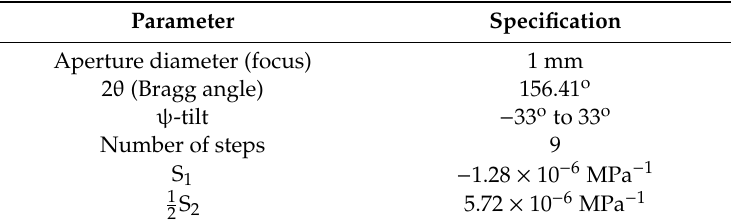
Figure 3. XRD residual stress measurement. Table 1. XRD parameters used.